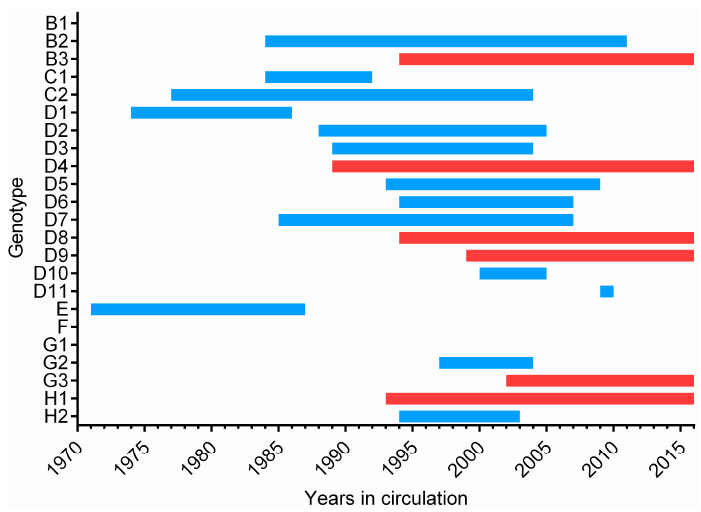
Figure 2. Year of first and last detection of Measles virus (MeV) wild-type genotypes. The first and last years of documented circulation reported to MeaNS for all 24 MeV genotypes is shown. First